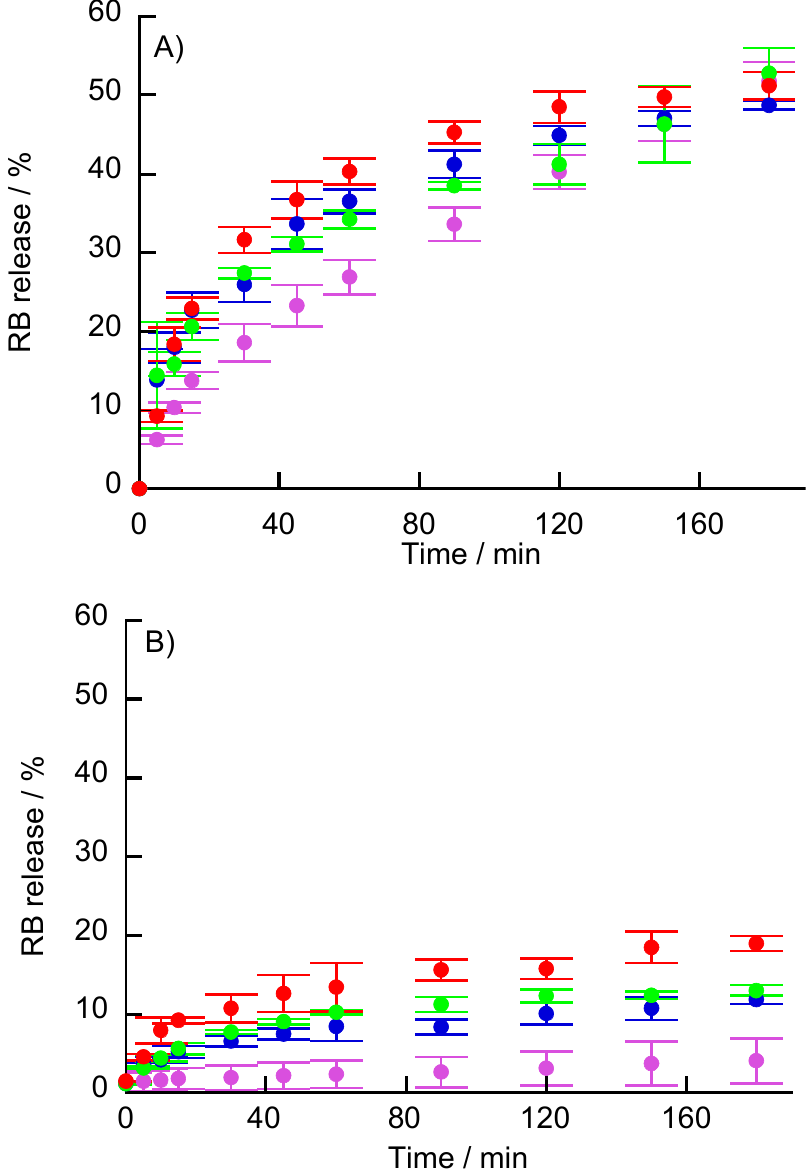
Figure 11. RB released from (PBA-PAMAM/PVA) 5 films immersed in H 2 O 2 solutions at ( A ) pH 7 and ( B ) pH 4. The H 2 O 2 solutions were working buffer solutions of 0 (purple), 1 (blue), 10 (green), and 100 mM (red) H 2 O 2 .